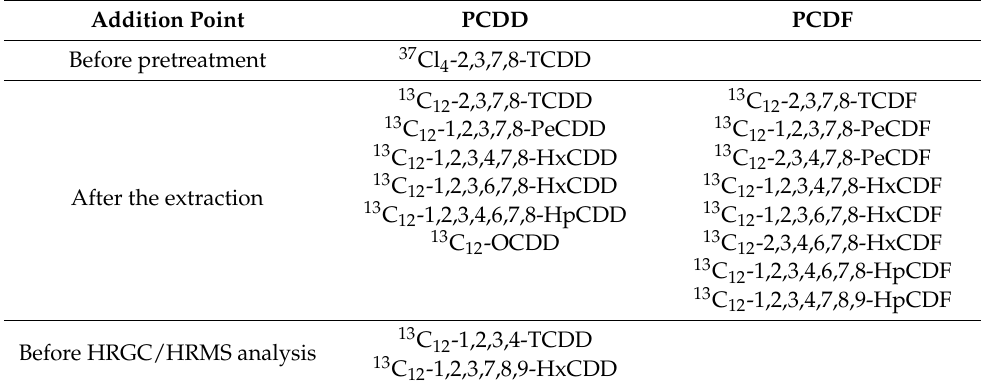
Table 2. Internal standard materials for PCDD/DFs analysis.